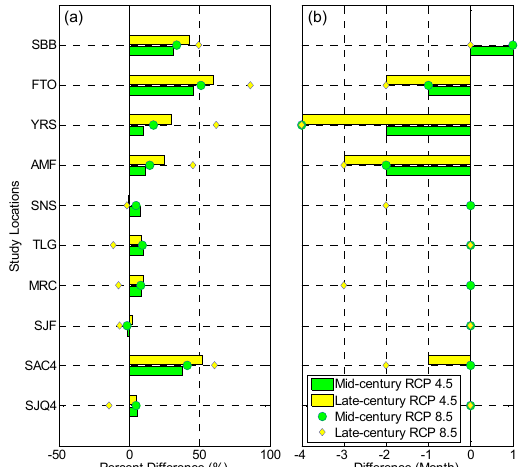
Figure 5. ( a ) Percent difference (%) between historical baseline and mean RCP 4.5 and mean RCP 8.5 projections on peak volume; ( b ) Shift in runoff peak timing (month) of mean RCP 4.5 and mean RCP 8.5 projections compared to the baseline in mid-century and late-century for all study locations.